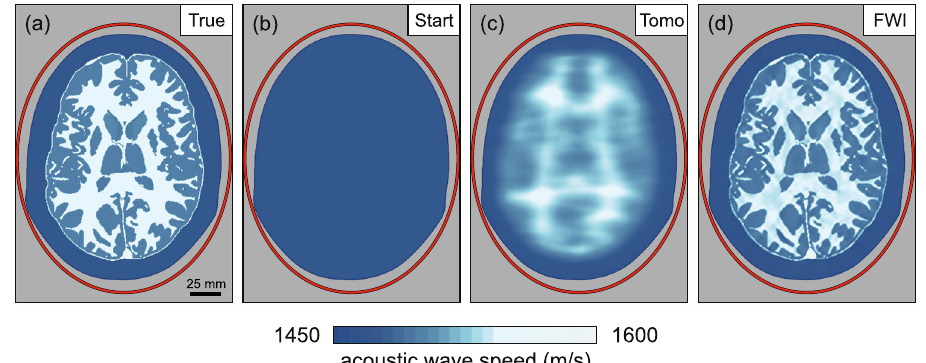
Fig. 2 Inversion of data from a brain outside the skull. a A two-dimensional model of acoustic wave speed in the naked brain without the skull. The red ellipse shows the transducer positions; the grey region is masked and held fi xed during the inversions. b Homogeneous model used to begin inversion. c Result of ultrasound computer tomography. The resultant model is accurate but has poor spatial resolution. d Result of ultrasound full-waveform inversion. The resultant model is now both accurate and spatially well